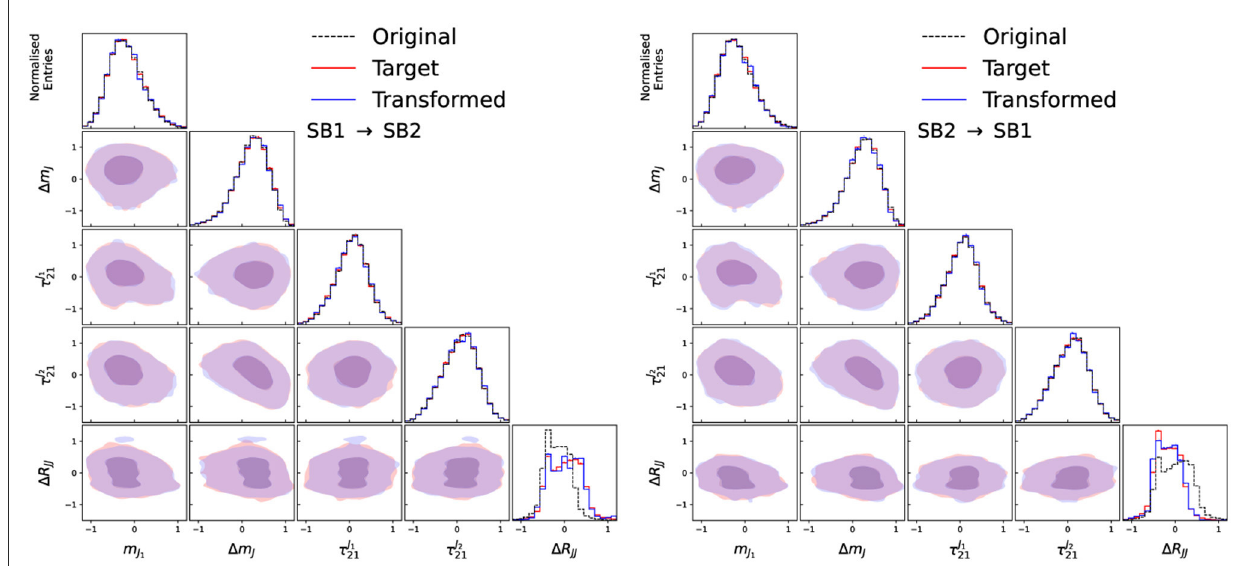
FIGURE3 Input, target, and transformed data distributions for the base variable set with the addition of 1 R JJ , for transforming data from SB1 to SB2 (left) and SB2 to SB1 (right) , with the model trained on SB1 (3,200 m JJ < 3,400 GeV) and SB2 (3,600 m JJ < 3,800 GeV). The data from SB1 (SB2) is ≤ ≤ transformed with a forward (inverse) pass of the C URTAIN s model into the target region. The diagonal elements show the individual features with the off diagonal elements showing a contour plot between the two observables for the transformed and trained